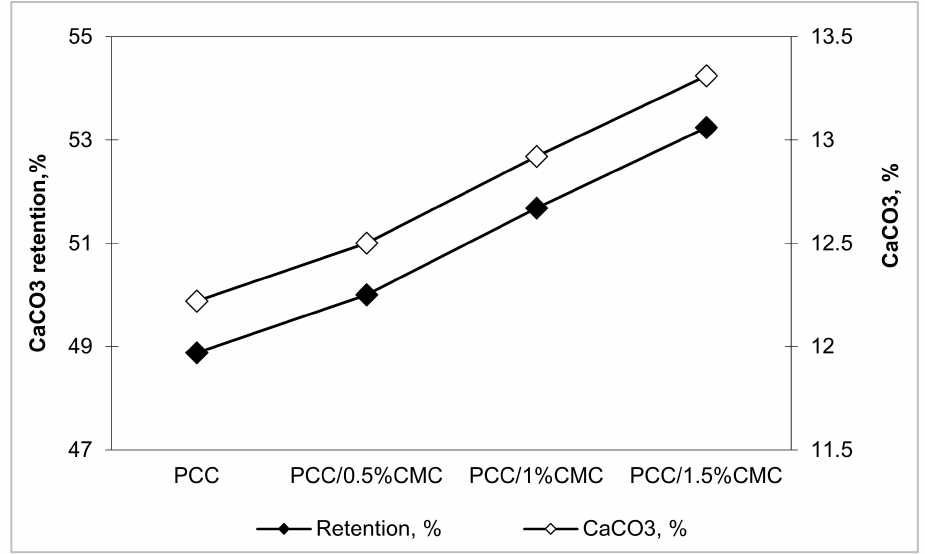
Figure 6. The influence of CMC addition on retention efficiency and calcium carbonate content in the